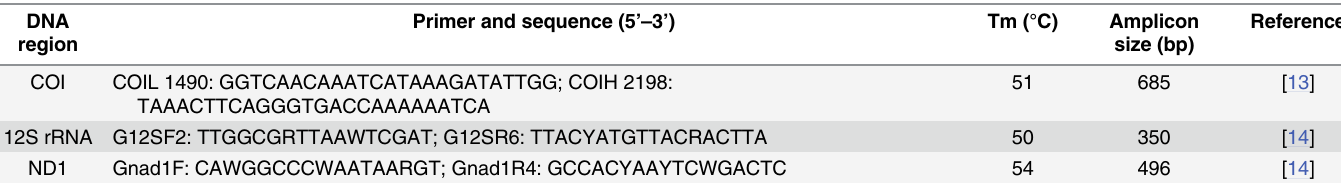
Primer and sequence (5 ’– 3 ’